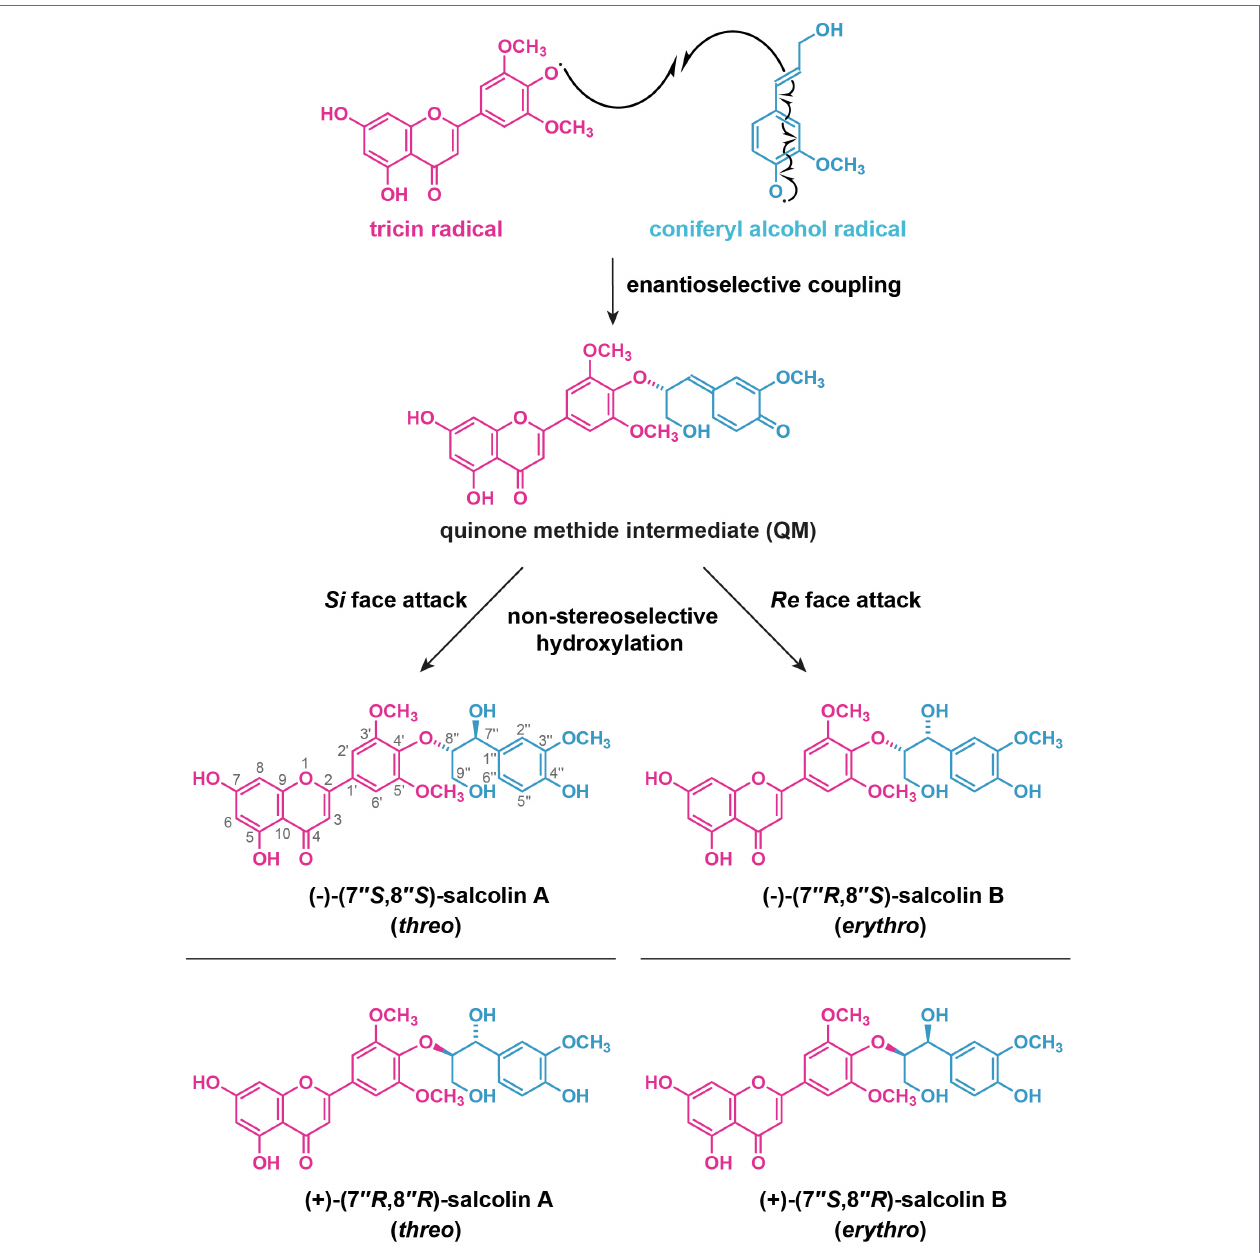
FIGURE 8 | A possible mechanism for the formation of optically active salcolin A and salcolin B through radical coupling of tricin and coniferyl alcohol. Different possible stereoisomers of salcolin A and salcolin B are